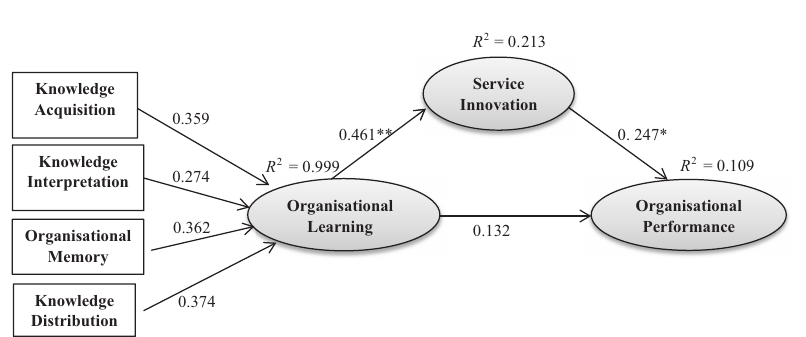
Figure 2. Structural equations